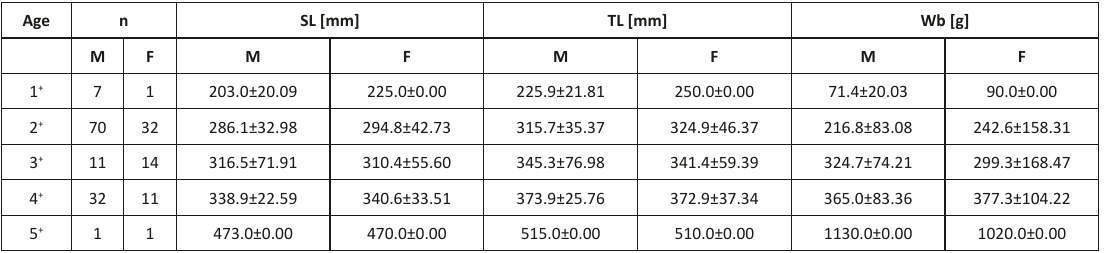
Table 2. Descriptive statistics and estimated parameters of length-weight relationships for P. indicus in the Persian Gulf Coastal Waters (number of individuals for all localities were 30).